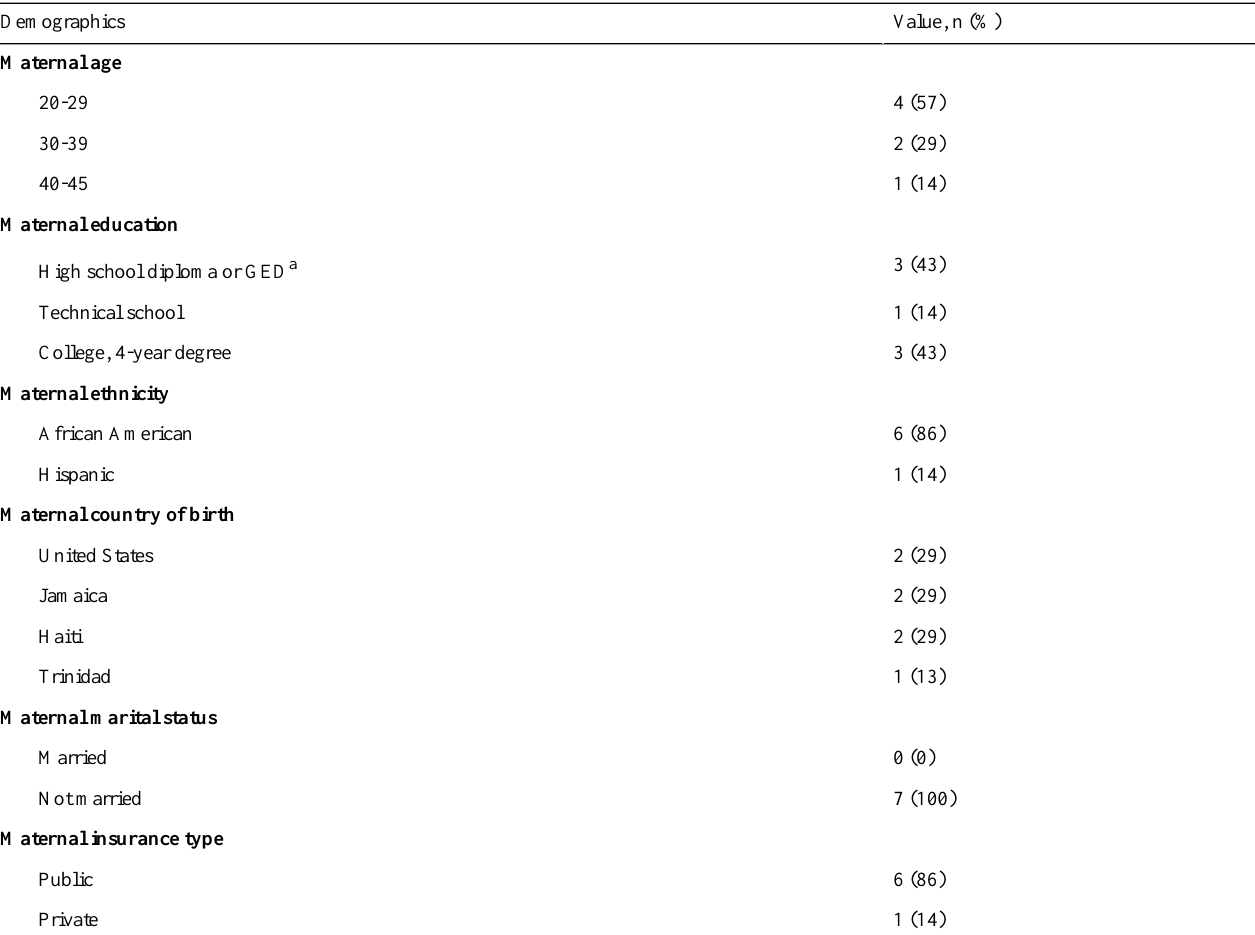
Table 3. Demographic characteristics of patients participating in focus groups and